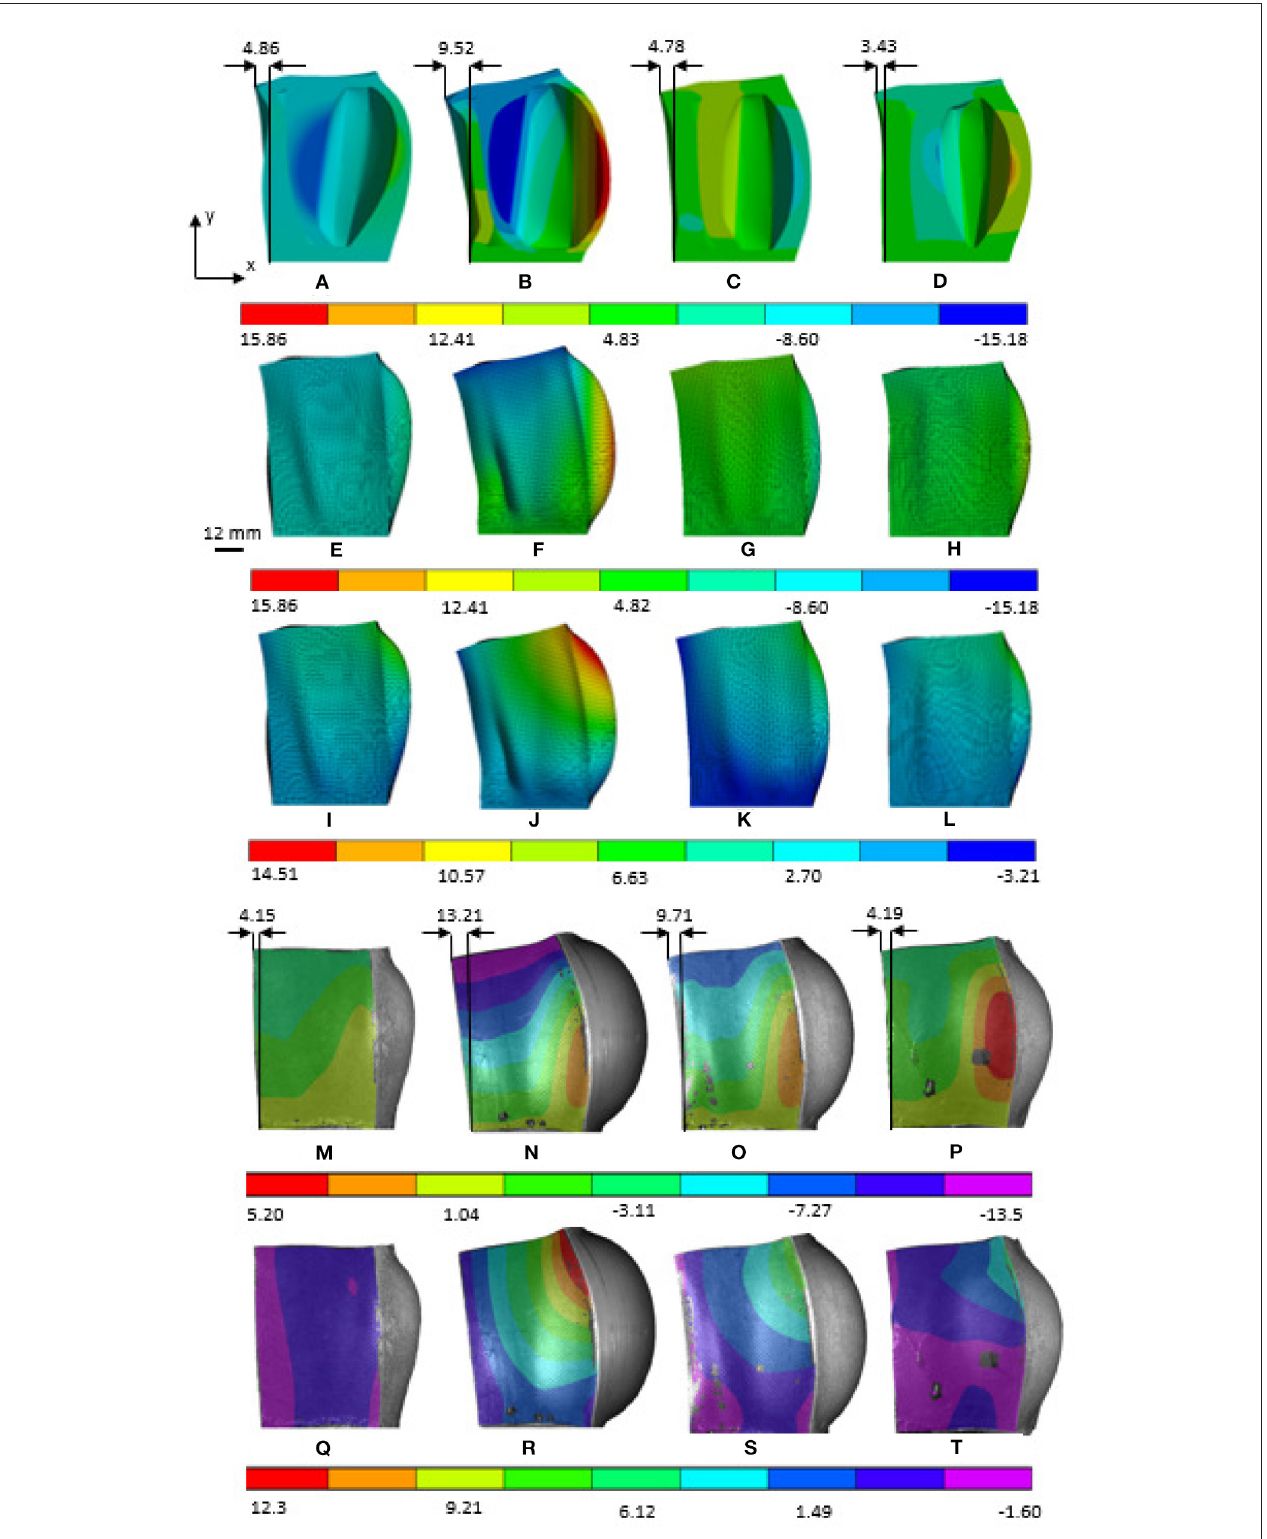
FIGURE 6 | ANSYS and DIC experimental results of horizontal motion in x direction and vertical motion in the y direction as shown in the figure. (A,E,I,M,Q) Original dome, (B,F,J,N,R) Model-based FA, (C,G,K,O,S) Model-based DDPG, (D,H,L,P,T) 8-DoF FE-based.